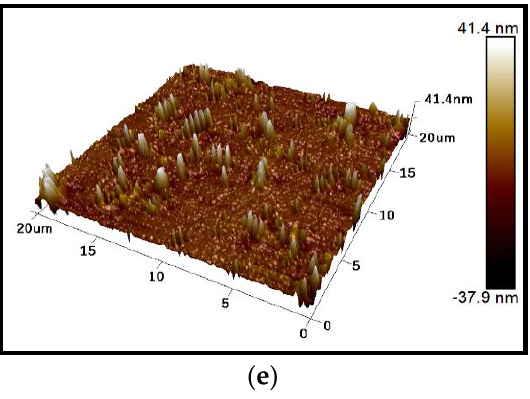
Figure 6. Bee-like structures of the asphalts: ( a ) SK-70; ( b ) SK-90; ( c ) KL-70; ( d ) Shell-70; and ( e ) SBS- modified.